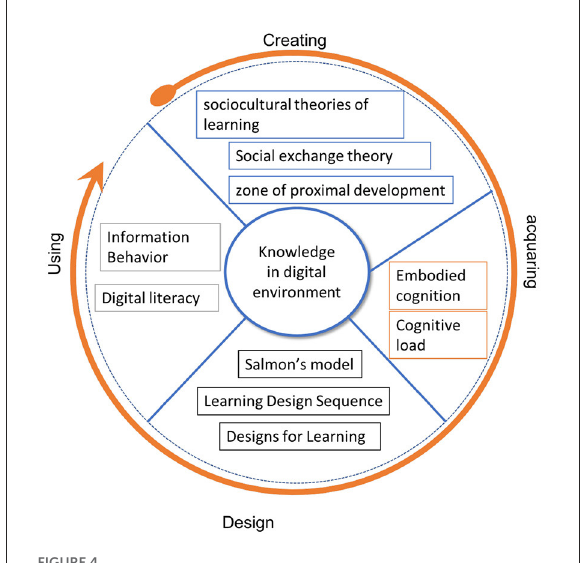
FIGURE4 Theories used in study to explain knowledge in digital